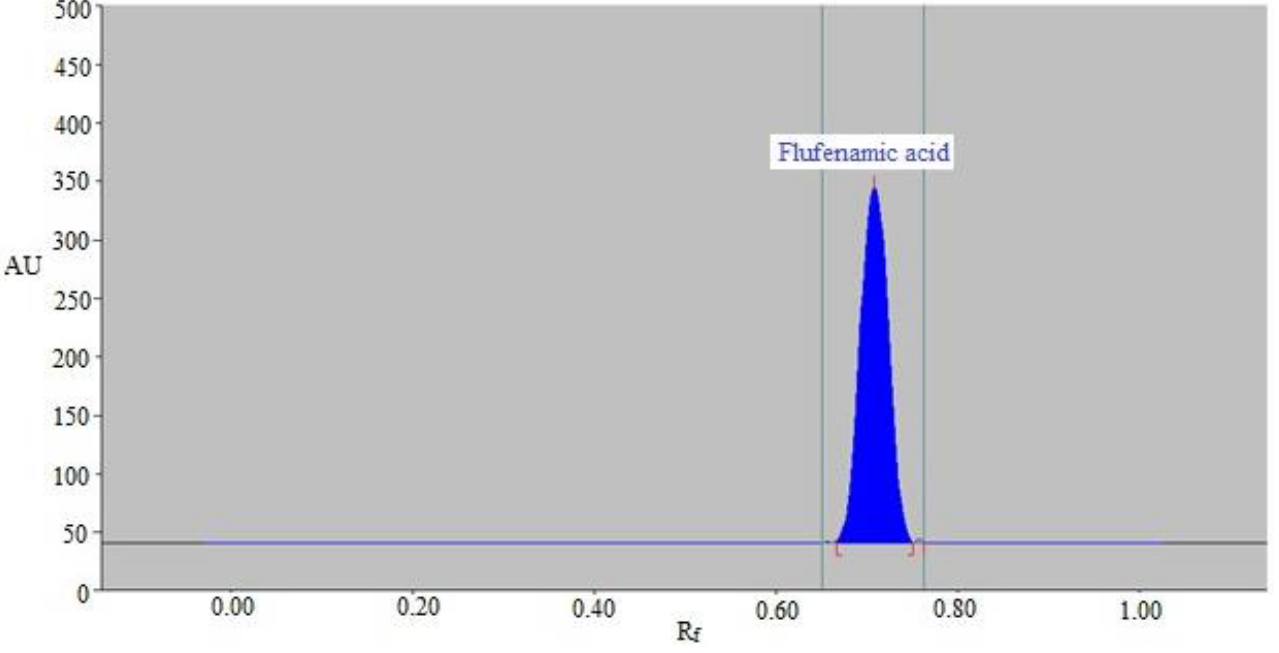
Figure 3. Representative chromatograms of standard FFA for the ecofriendly HPTLC assay.